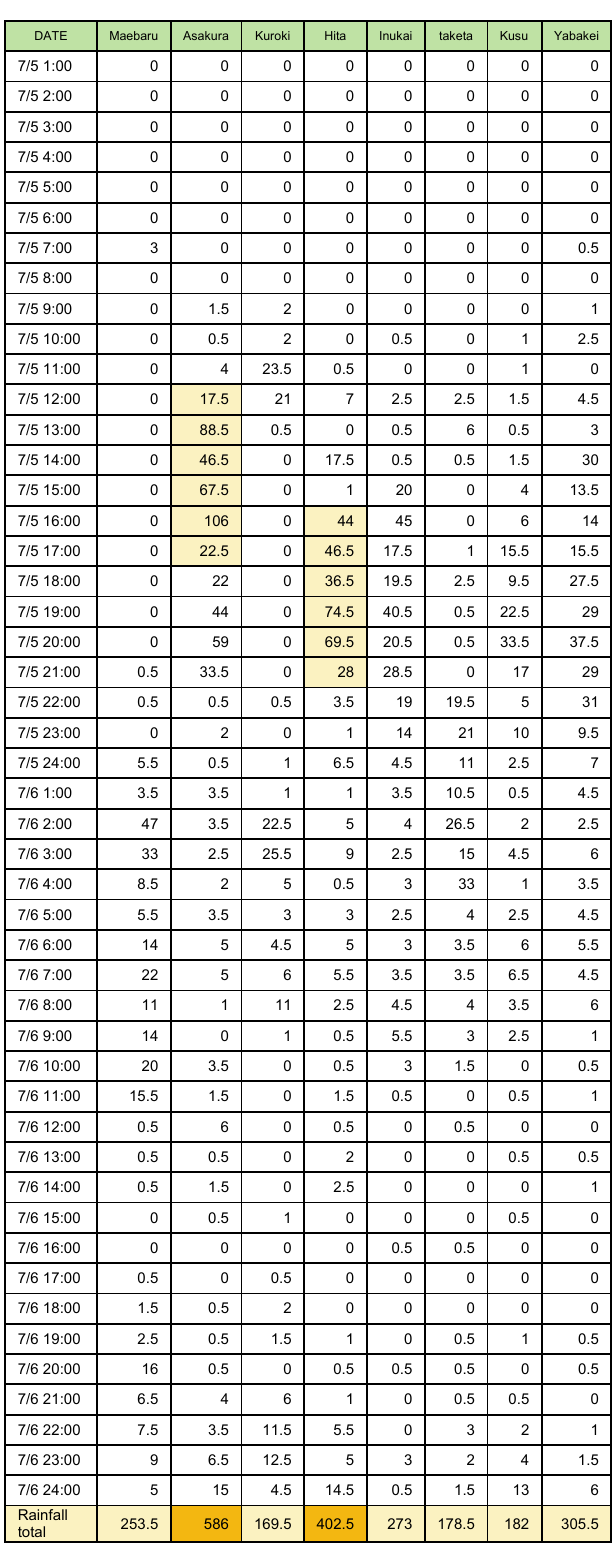
Table 1. Hourly precipitation measured by JMA AMeDAS